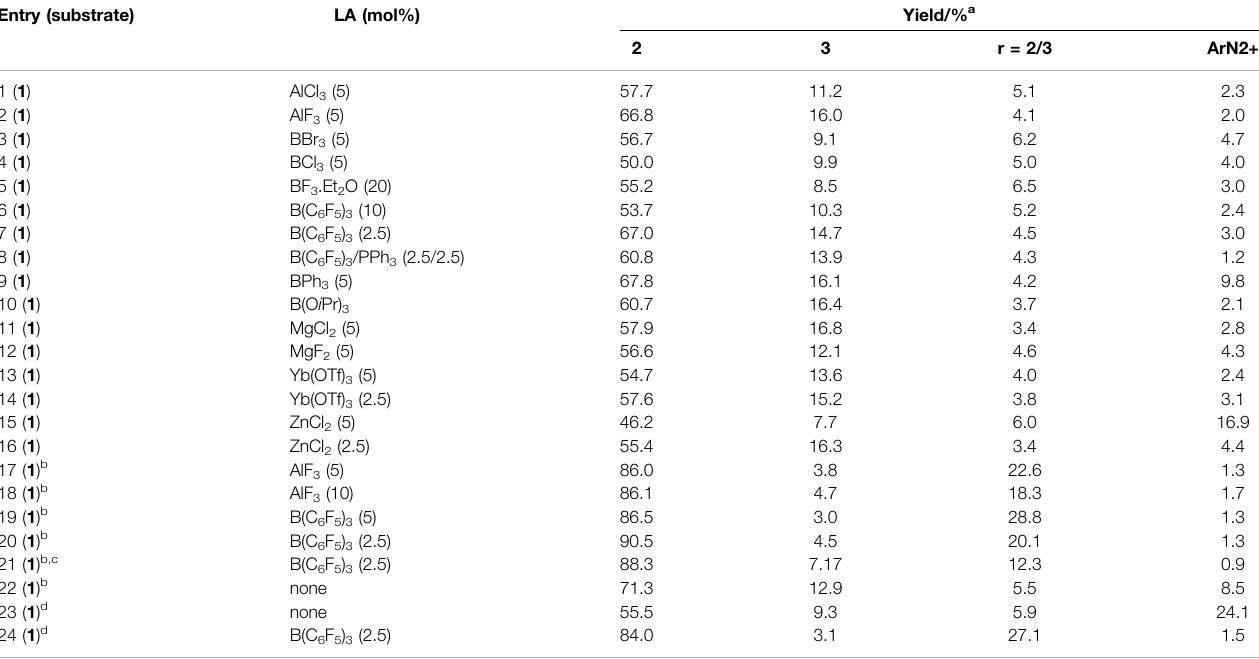
TABLE 2 | Effect of Lewis acids on the product spectrum. Entry